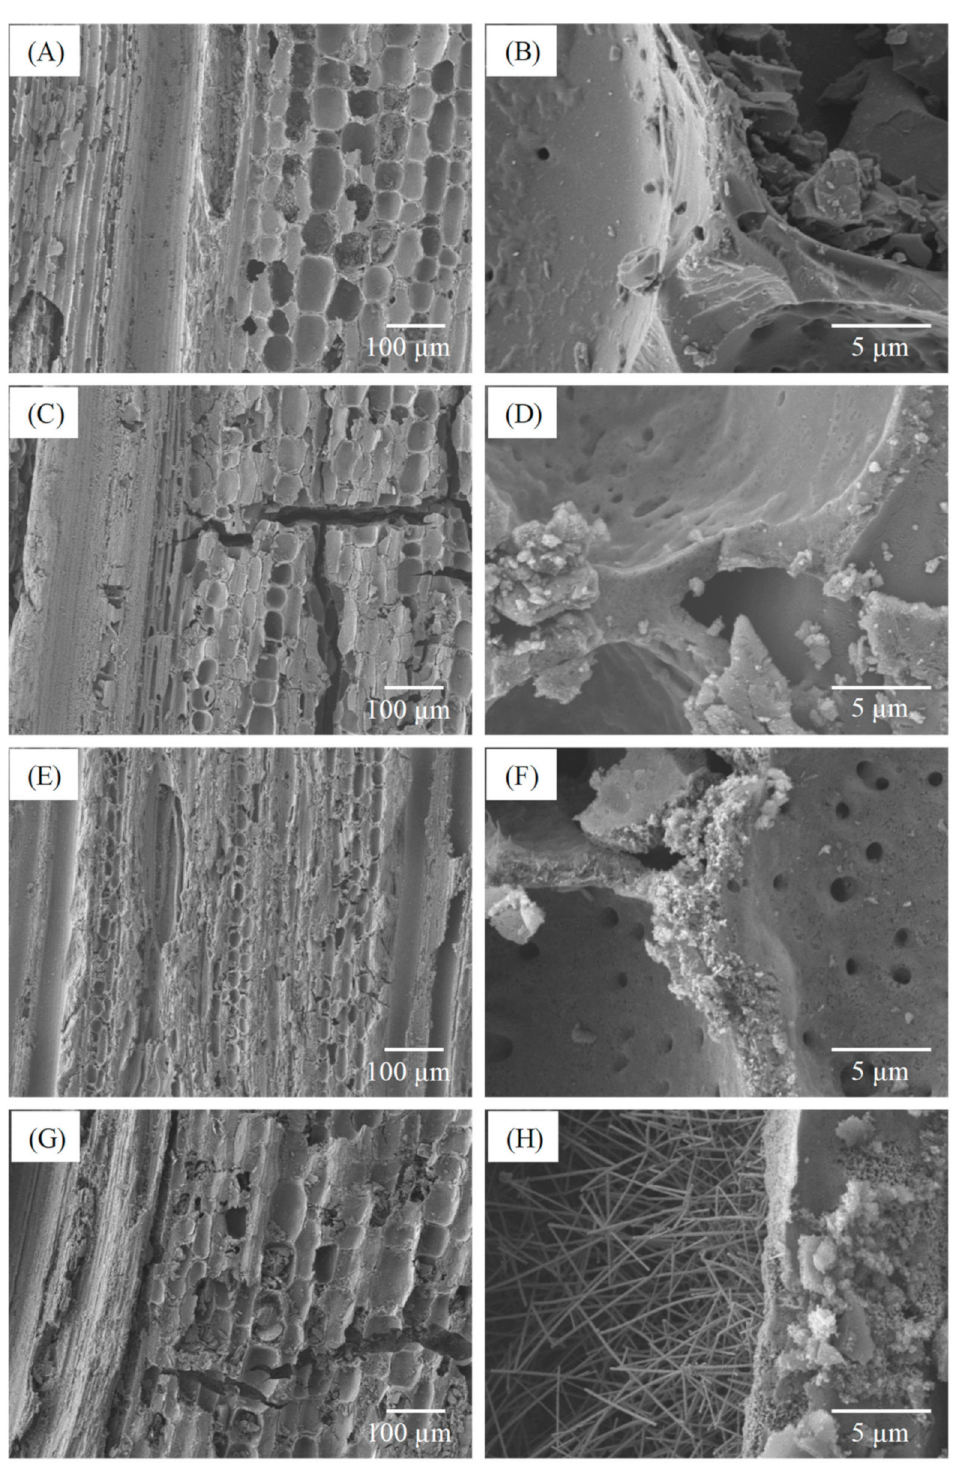
Figure 3. Scanning electron microscopy (SEM) micrographs of bamboo charcoal ( A , B ) and BcSiCs sintered at 1500 ◦ C ( C , D ), 1600 ◦ C ( E , F ), and 1700 ◦ C ( G , H ) for 2